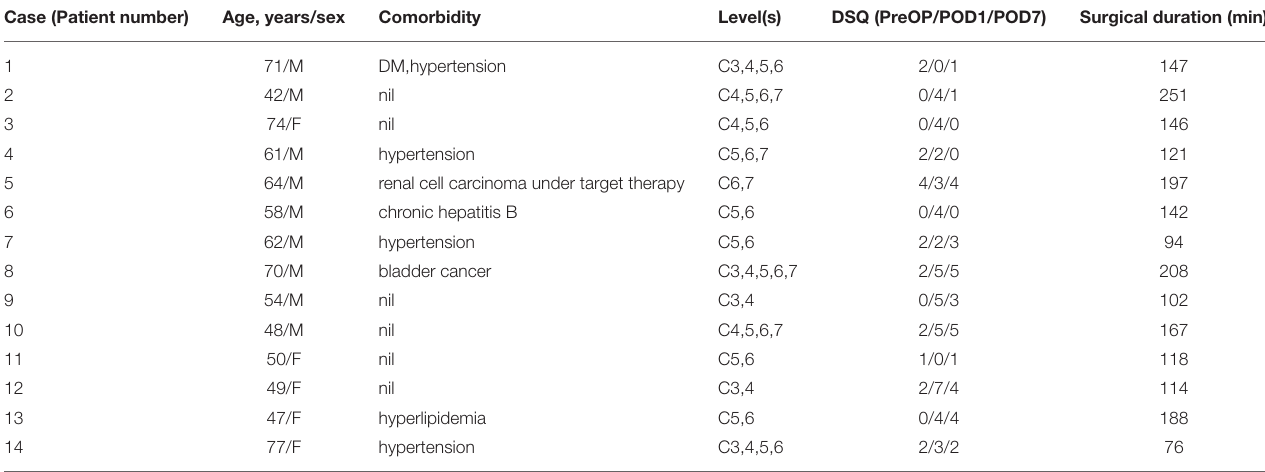
TABLE 2 | Demographics and contributing factors of 14 patients associated with perioperative swallowing changes. Case (Patient number)